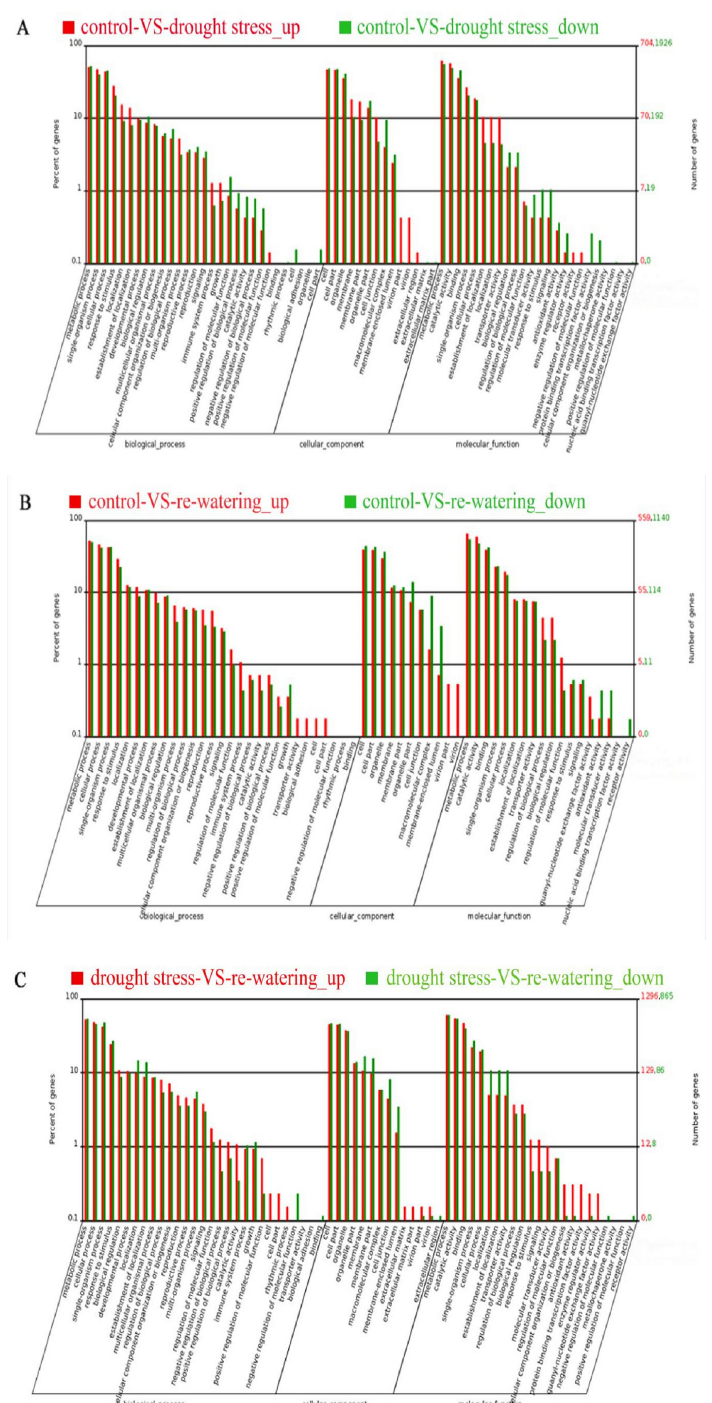
Fig 5. Gene Ontology (GO) categorization of the differentially expressed genes in the three comparison groups.